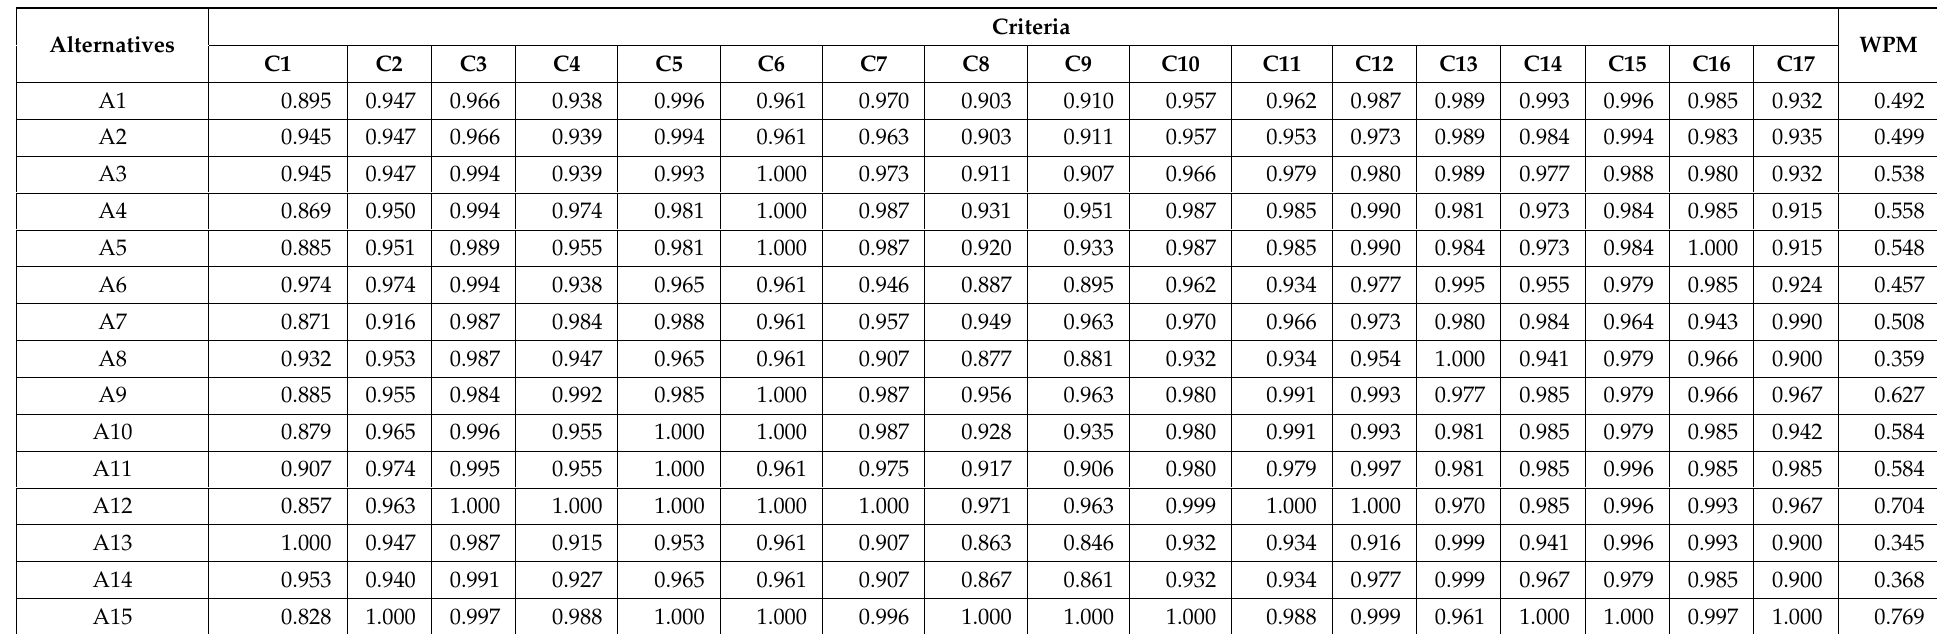
Table 6. Matrix for the weighted product method